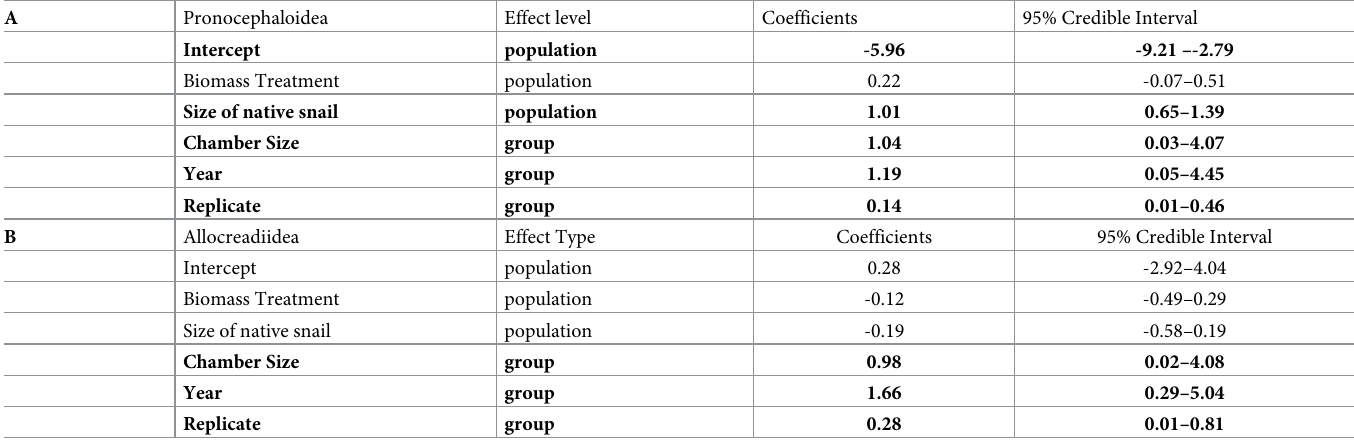
Table 4. Model coefficients and credible intervals for specific trematode taxa. How infection status of the native snail Pyrgulopsis by trematodes of the SuperFamilies (A) Pronocephaloidea and (B) Allocreadiidea was affected by biomass of Potamopyrgus (Biomass Treatment: Control, with no Potamopyrgus , Ambient levels of Potamo- pyrgus in Polecat Creek, and High biomass) in Bayesian multilevel models [39, 40]. Variables that significantly affected infection status are bolded. For the group level effects, values in the Coefficients column are standard deviations for the Coefficient